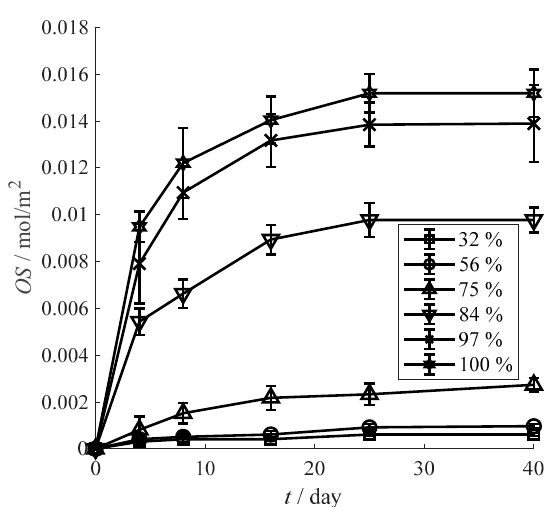
Figure 6. Influence of humidity on the oxygen scavenging performance.